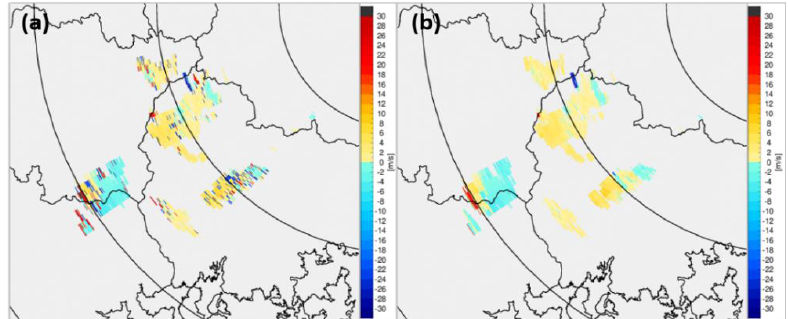
Figure 9. PPIs of radial velocity ( a ) before and ( b ) after noise correction at an elevation angle of −0.8° for MYN at 1610 LST on 6 June 2020.